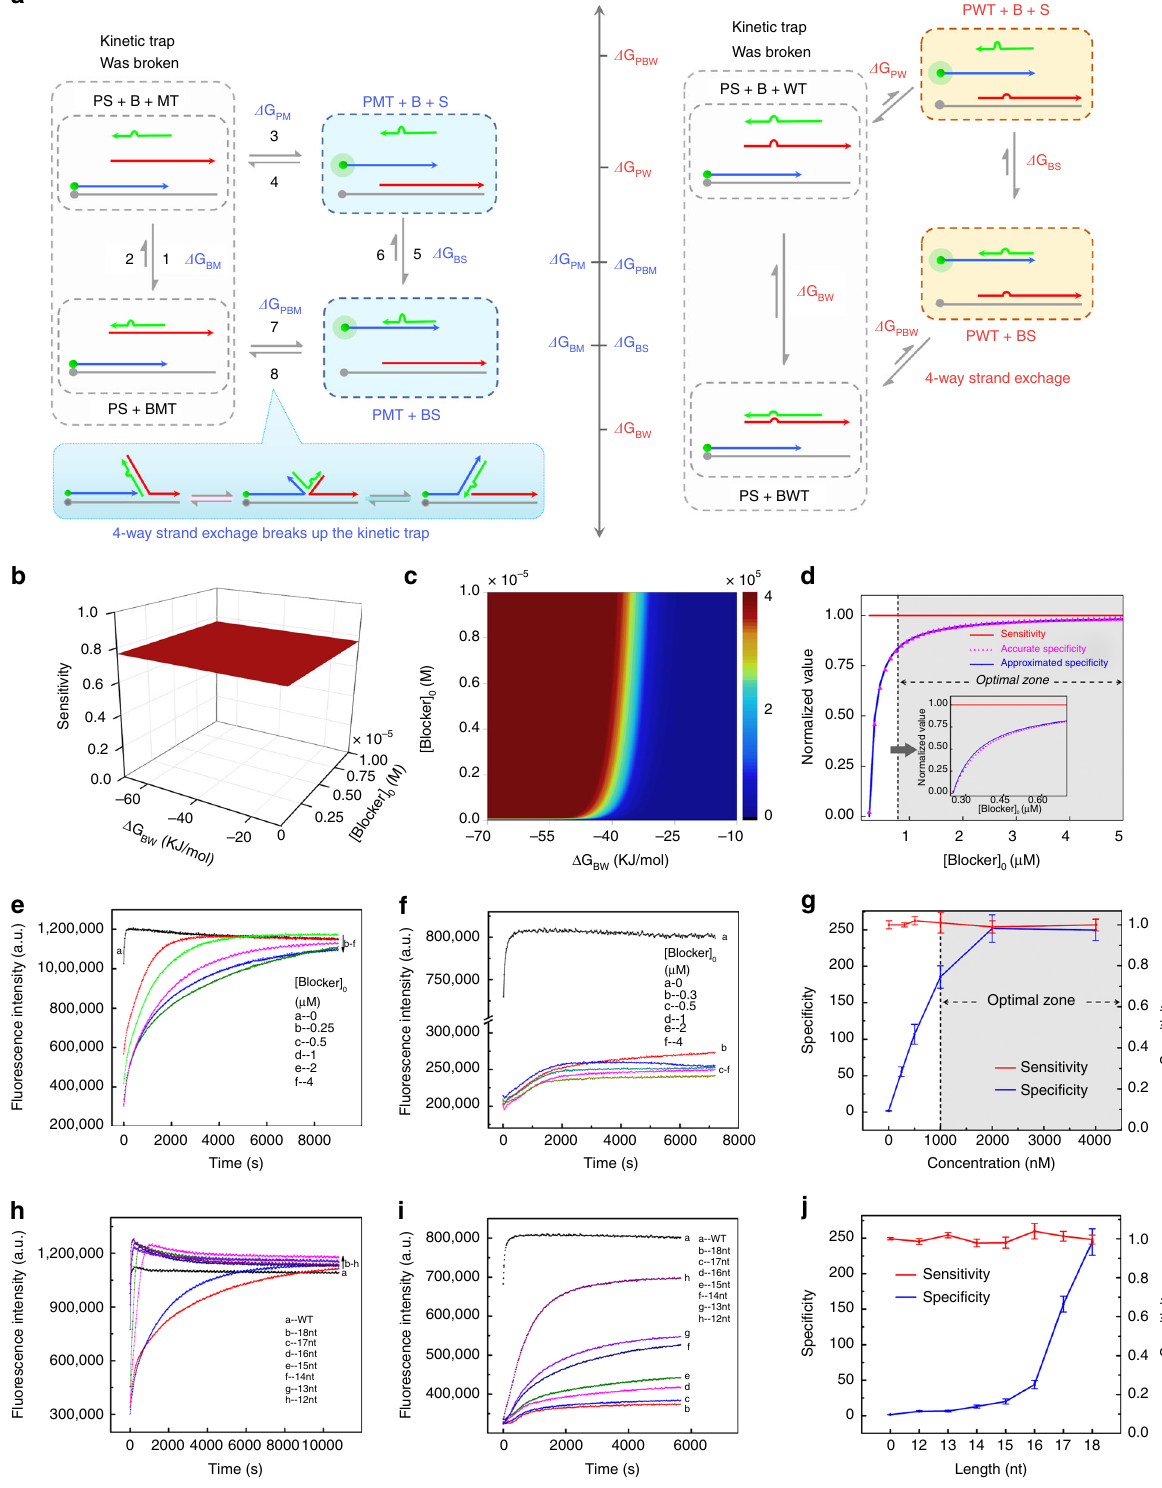
Fig. 3 Modelling and veri fi cation of the dissociative 4-way SELECT system. a The reaction pathways and the levels of associated free energy changes. b – c Calculated sensitivity ( b ) and speci fi city ( c ) of the system over [Blocker] 0 and Δ G BW . d Two-dimensional interception curves of sensitivity and speci fi city extracted from ( b ) and ( c ). The value of Δ G BW was fi xed at − 71421J mol − 1 . e , f The fl uorescence intensity of the system towards MT ( e ) and WT ( f ) with the concentration of blocker ranging from 0 to 4 μ M. The length of blocker was fi xed at 18-nt. g The sensitivity and speci fi city of the system over [Blocker] 0 . h – i The fl uorescence intensity of the system towards MT ( h ) and WT ( i ) with the length of blocker ranging from 12 nt to 18 nt. The concentration of blocker was fi xed at 4 μ M. j The sensitivity and speci fi city of the system over blocker length. Error bars are s.d. of three repeated experiments. Source data are provided as a Source Date fi